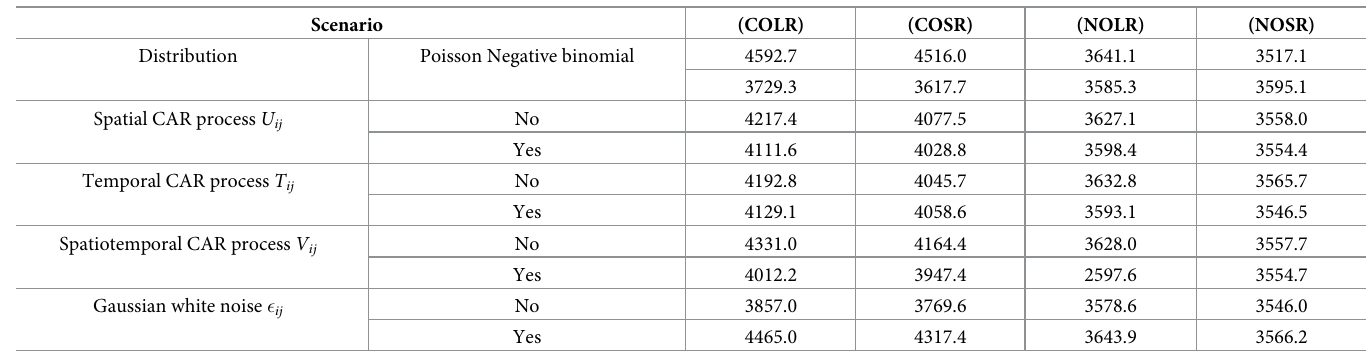
Table 3. Average DIC